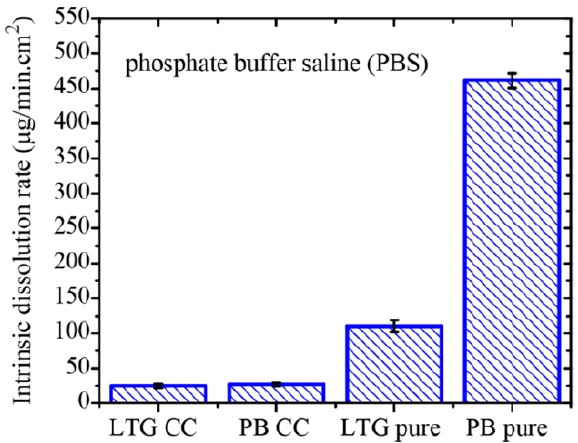
Figure 40. Comparison of Intrinsic Dissolution Rate (IDR) of lamotrigine from cocrystal (LTG CC), phenobarbital from cocrystal (PB CC), pure lamotrigine drug (LTG pure) and pure Phenobarbital drug (PB pure) [Reprinted from [329] with permission. Copyright 2017 American Chemical Society].